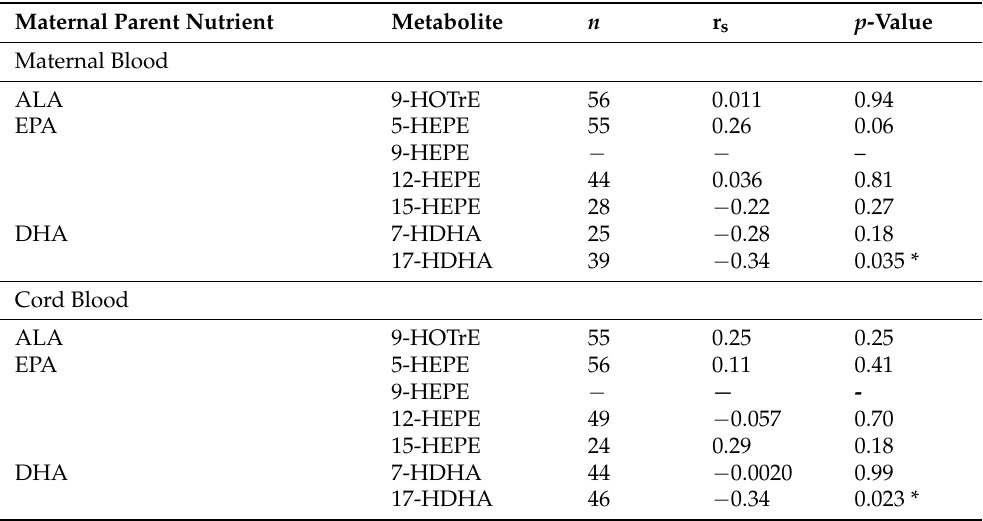
Table 6. Correlations between maternal plasma levels of parent nutrients ( µ g/mL) and maternal and umbilical cord metabolite levels.